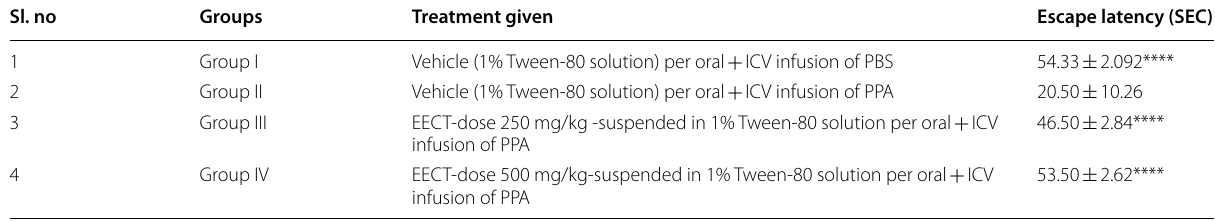
Values are represented in Mean Comparison: Group II vs Group I,Group II vs Group III, and Group II vs Group IV ns, non significant